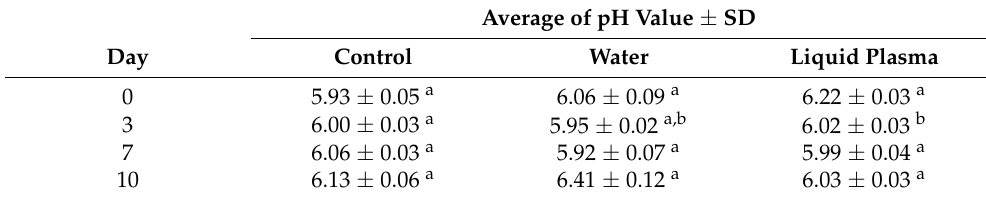
Table 7. Averages of the pH value on the surface of the chicken samples ( n = 9).